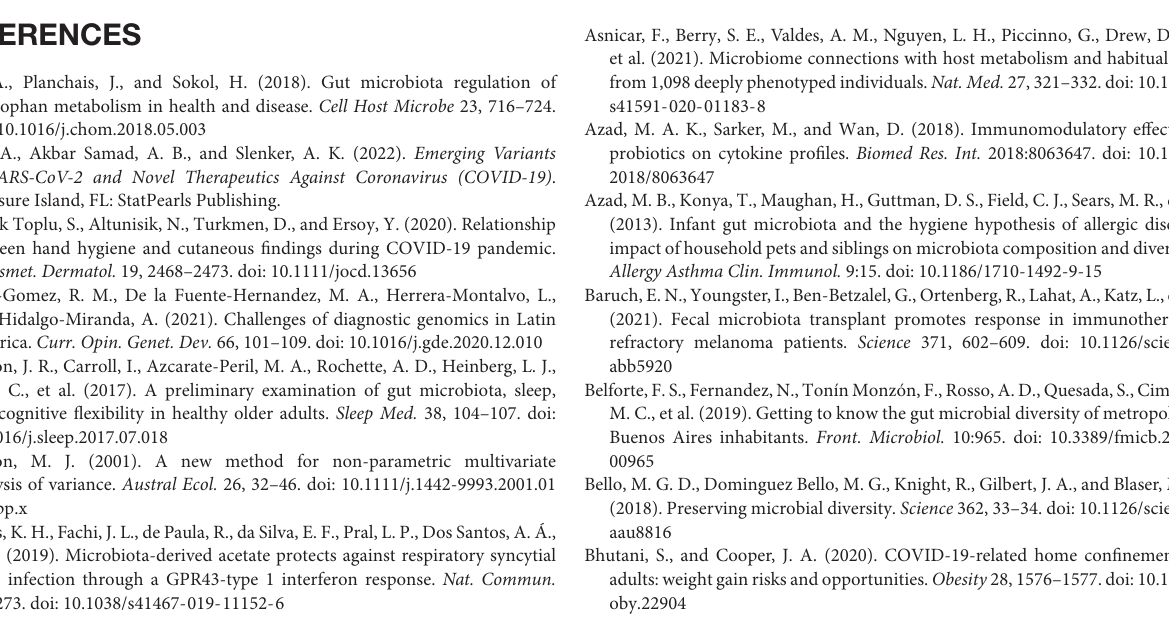
Supplementary Figure 1 | Number of COVID-19 cases, confirmed deaths and public transportation usage in Buenos Aires city in 2020. The pink bar represents the first day of PCSI in Argentina. Supplementary Figure 2 | PCoA plots of beta diversity, (A) weighted PCoA1 vs. PCoA3 (B) weighted PCoA2 vs. PCoA3 UniFrac distances and (C) unweighted PCoA1 vs. PCoA3 (D) unweighted PCoA2 vs. PCoA3 UniFrac distances, respectively. Ellipses represent the 95% confidence interval of each group. Colors are assigned by group, red for PPG and blue for PG. Supplementary Figure 3 | Relative abundance and prevalence of the different phyla of the gut microbiota in each subject in the PPG and PG. Supplementary Figure 4 | Unweighted UniFrac PCoA plots of beta diversity with significant vector correlation by fitting metadata and ASVs vectors on ordination space for bacterial communities. Factors shown had a significant correlation with ordination axes ( p < 0.05). Supplementary File 1 | Pipeline for data analysis used in this